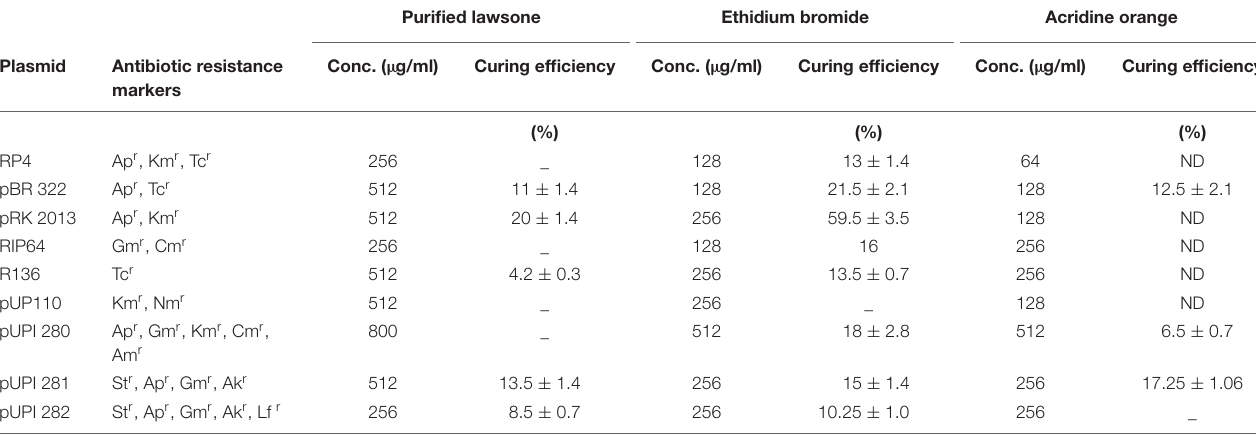
TABLE 4 | Curing of R plasmids with conventional curing agents.